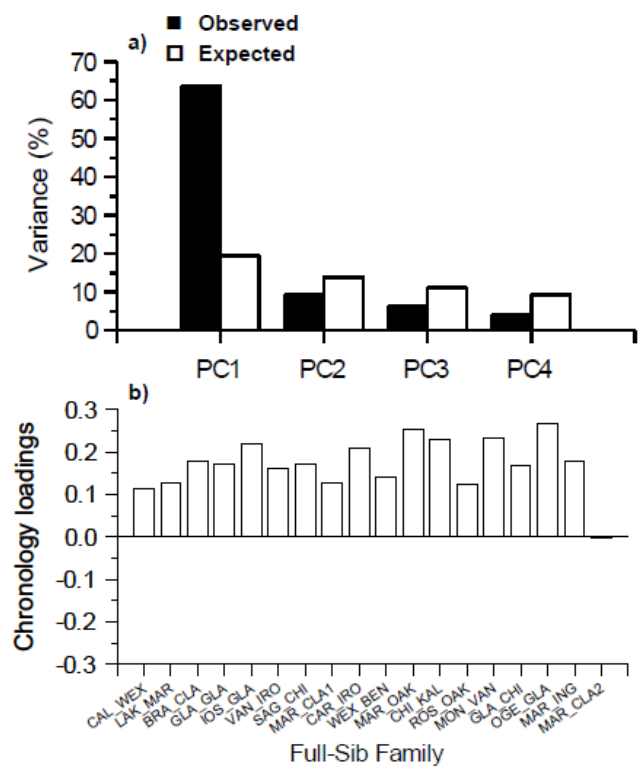
Figure 3. Principal component analysis of the basal area index (BAI) growth chronologies of all 18 full-sib families of hybrid poplar ( P. × smithii ): (a) percentage of the observed total variance explained by each of the first four principal components (PC1-PC4) compared with the expected values from the broken stick null model [36,37]; and (b) loadings of each of the BAI chronologies of the 18 full-sib families onto